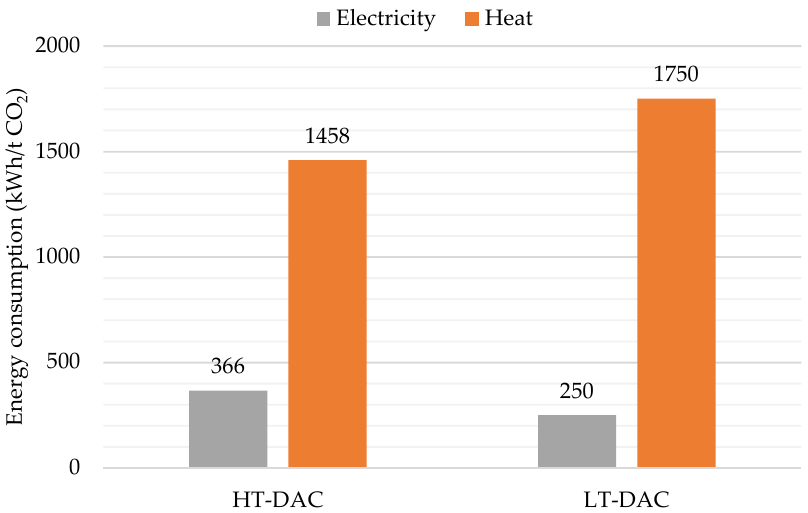
Figure 2. Comparison of the energy requirements per captured ton of CO 2 for each technology. Figures for high-temperature DAC (HT-DAC) and low temperature DAC (LT-DAC) are extracted from the works of Keith et al. [32] and Fasihi et al. [31], respectively. For those figures specified in ranges, the average value was taken.